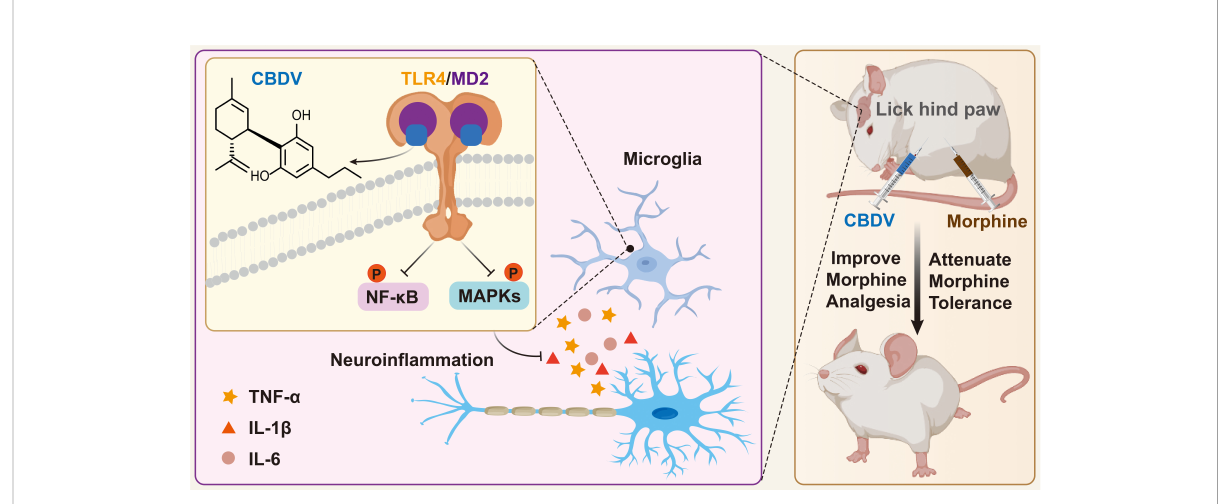
FIGURE 9 A schematic illustration of the role of CBDV in modulating TLR4 signaling via targeting MD2. CBDV binds to TLR4 co-receptor MD2, inhibits TLR4 signaling NF- k B and MAPKs, and suppresses downstream pro-in fl ammatory cytokines TNF- a , IL-1 b and IL-6. By inhibiting microglial- induced neuroin fl ammation, CBDV improves morphine-mediated